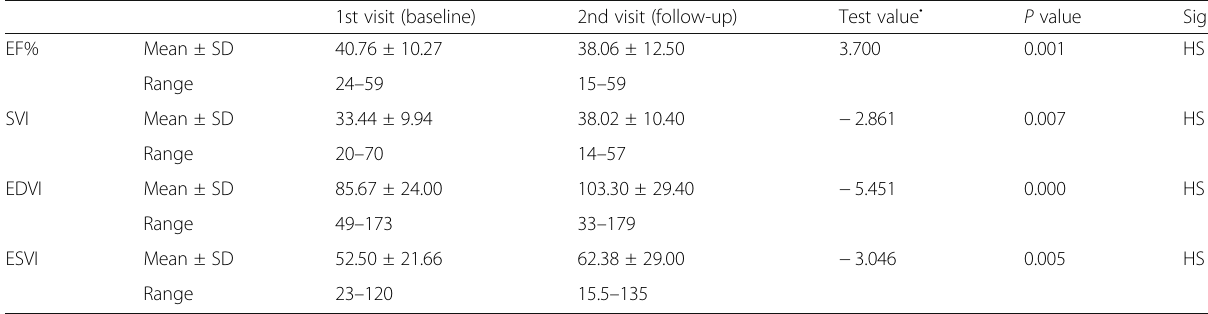
Table 2 Paired comparison of LVEF% and LV volumes at 1st (baseline) and 2nd (follow-up) visits in all cases ( n = 33) 1st visit (baseline) 2nd visit